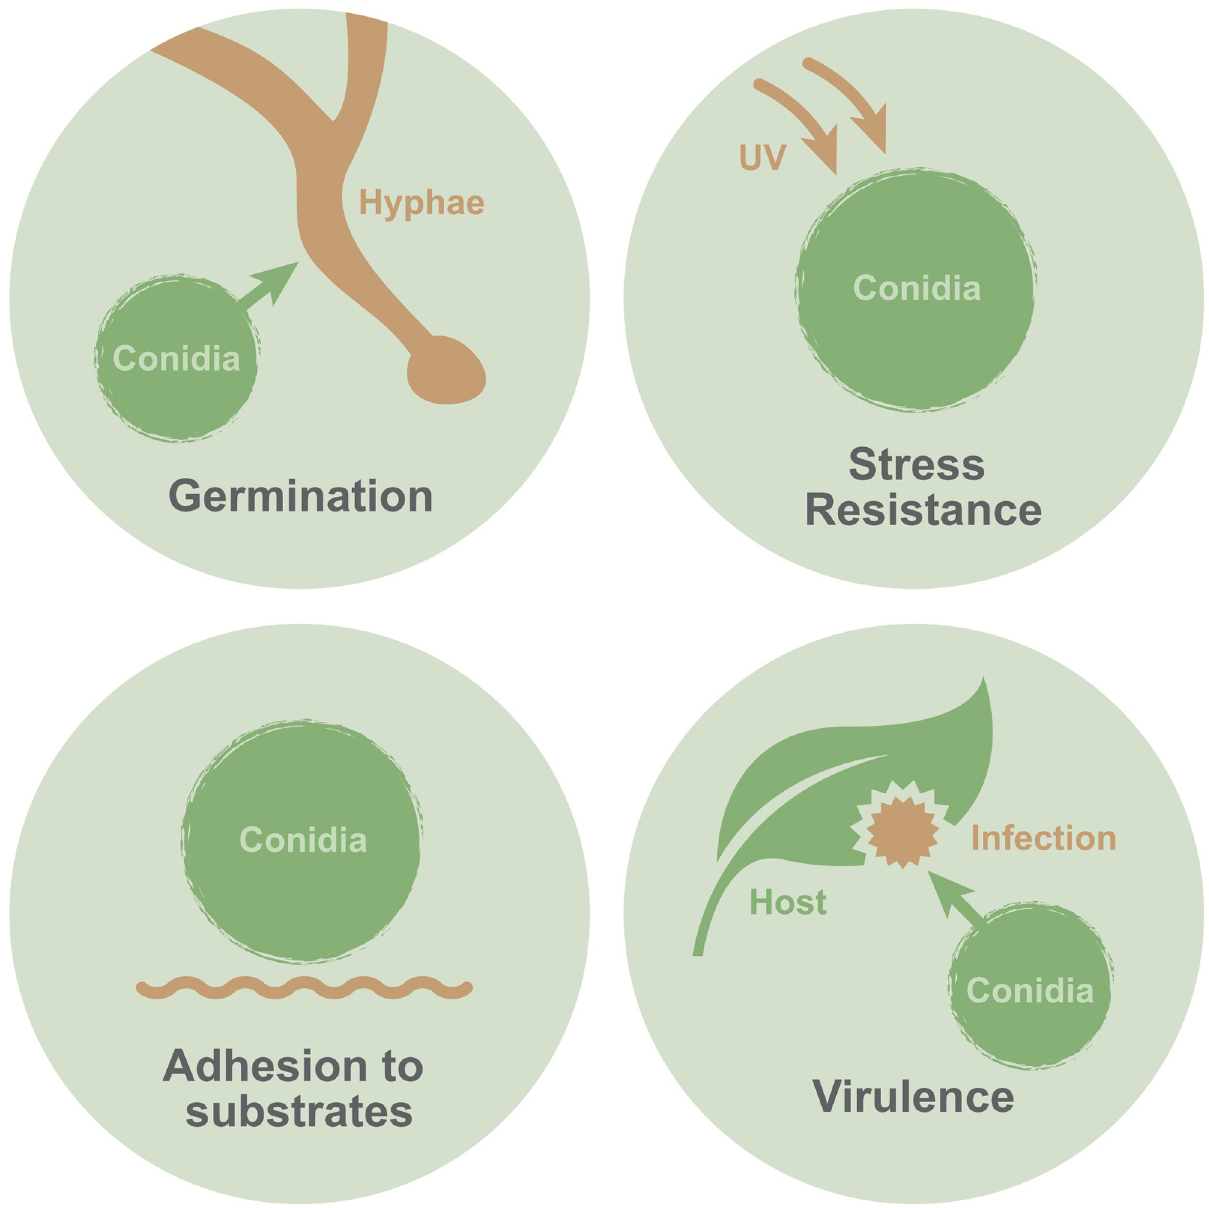
Fig 1. Conidial surface proteins have many roles. Proteins on the surface of conidia are involved in a variety of important functions. In particular, these proteins contribute to germination, stress resistance, adhesion to substrates, and virulence.